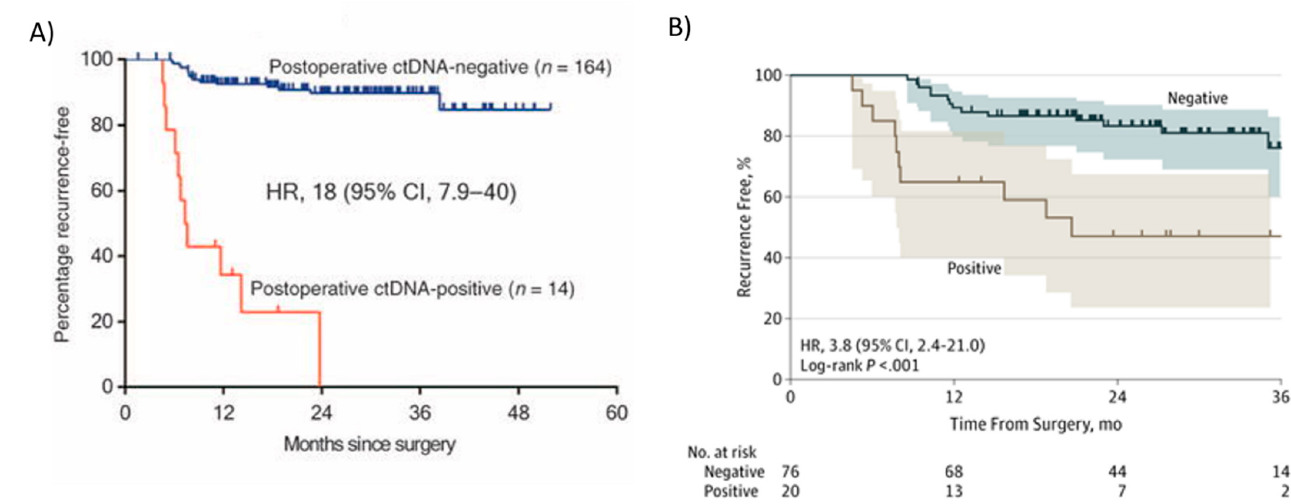
Figure 4. Kaplan–Meier estimates of recurrence-free interval according to ctDNA status in patients with stage II and III colon cancer after surgery (postoperative). In ( A ) Recurrence-free survival (RFS) in colorectal stage II patients post-surgery not treated with adjuvant chemotherapy. Patients with ctDNA-positive status postoperative had a markedly reduced RFS compared with those with a ctDNA-negative status. From Tie et al. [21]; ( B ) Kaplan–Meier estimates of recurrence-free interval according to ctDNA status in patients with stage III colon cancer after surgery. From Tie et al. [123]. Tie et al. [123] also studied ctDNA in stage III colon cancer patients. In this study, ctDNA was detectable in 20 out of 96 (21%) patients postoperatively (4–10 weeks after surgery), and the recurrence-free survival (RFS) at 3 years in this group was 47% (95% CI, 24–68%) compared to 76% in those with undetectable postoperative ctDNA (95% CI, 61– 86%) (Figure 4B) [123]. Patients with detectable ctDNA after surgery had an increased risk